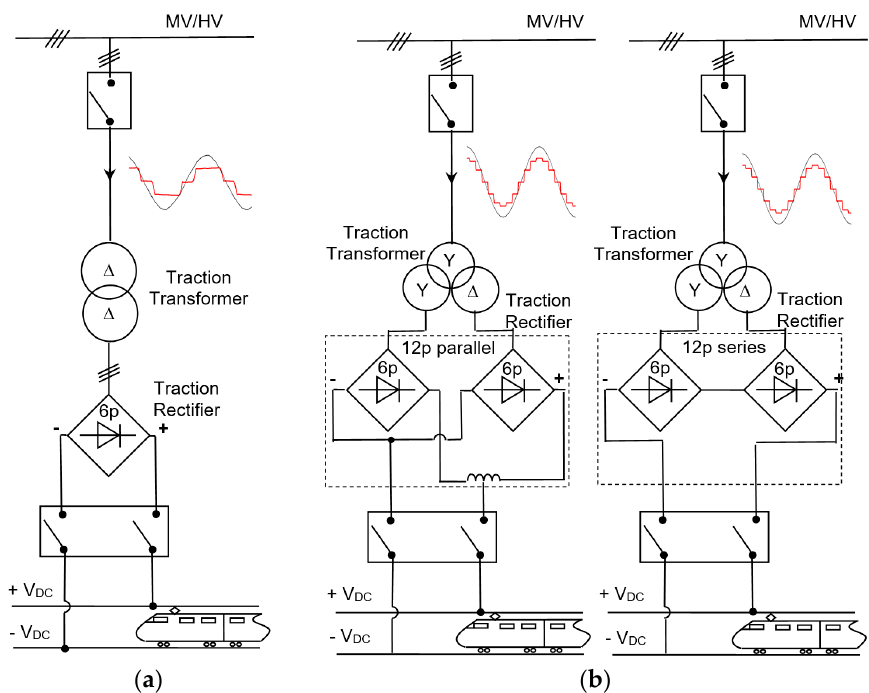
Figure 1. Simplified schemes of the usual DC-traction substations and specific waveforms of the supply phase current and voltage: ( a ) case of 6-pulse uncontrolled rectifier and ( b ) case of 12-pulse parallel and series uncontrolled rectifier.